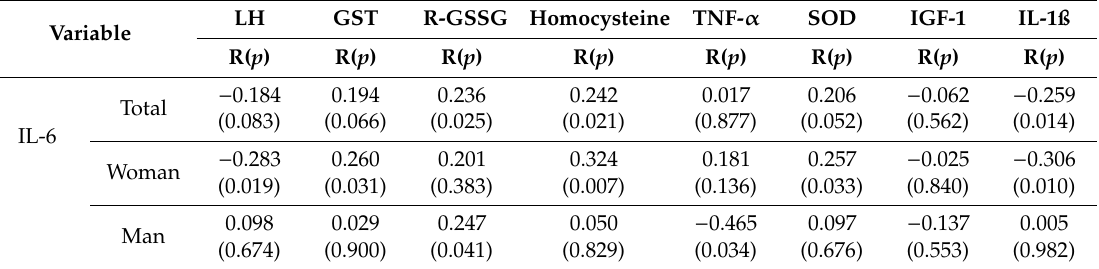
Table 6. The Spearman rank correlation analysis for IL-6, including selected variables in the general group, men and women.